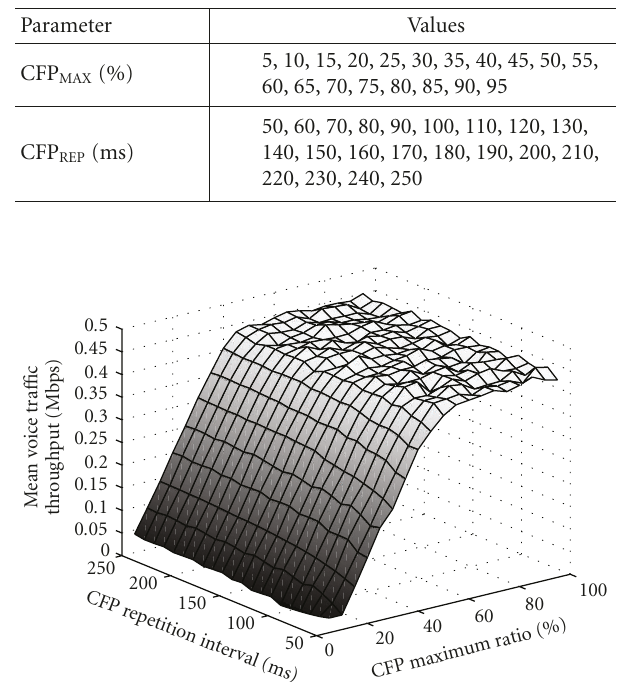
Table 1: Summary of model parameters. Table 2: Simulated CFP MAX and CFP REP values.